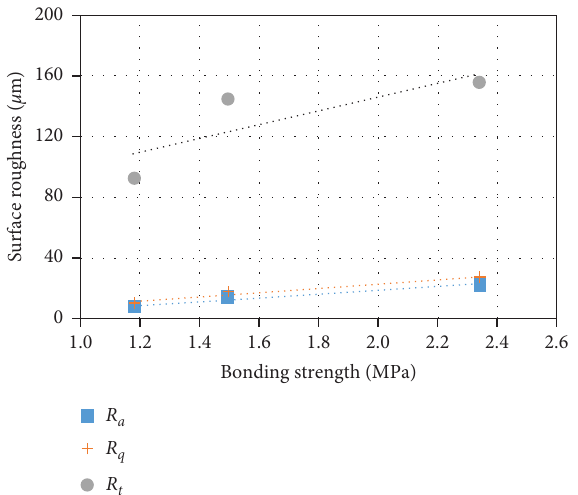
Figure 7: Relationship between the bonding strength and surface roughness of